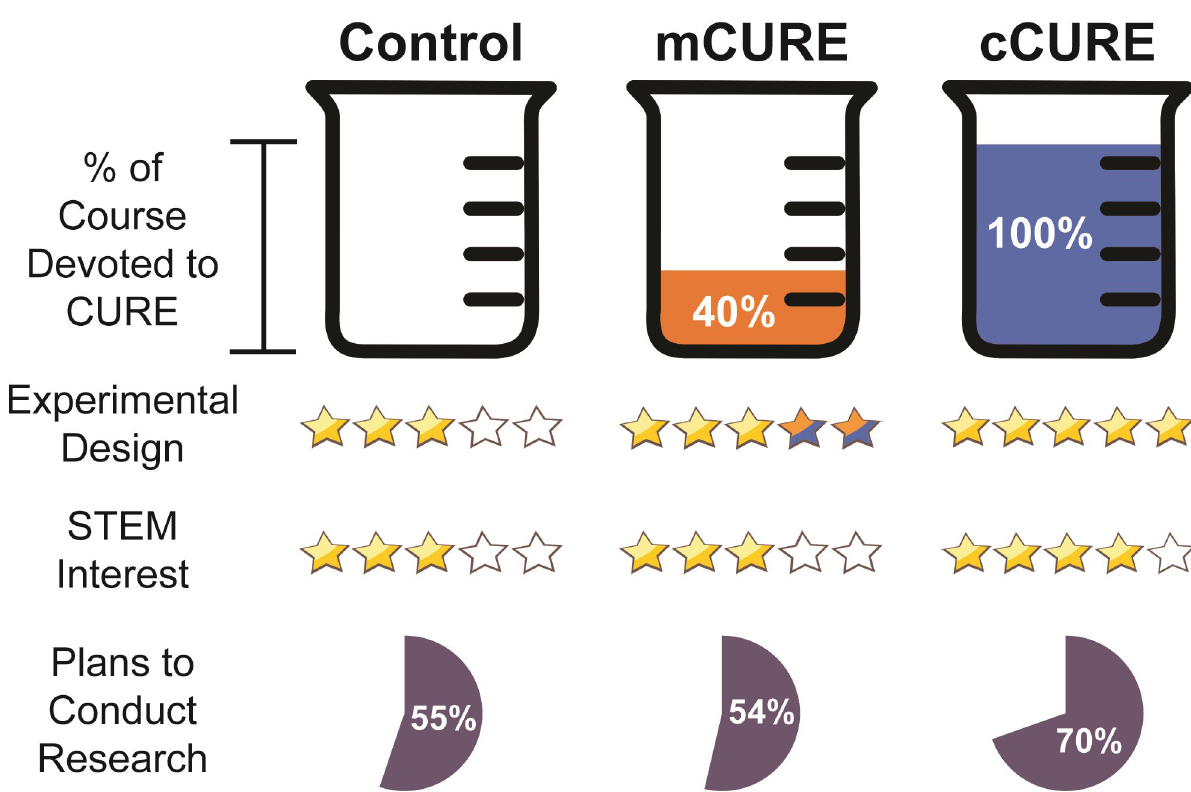
Fig 11. Overall student outcomes. The CURE courses included more time in the course devoted to elements of a CURE. Student improvement in experimental design was higher in cCUREs than controls, while mCURE students were not significantly different than either. STEM interest and plans to conduct future research were higher in cCUREs compared to mCUREs and